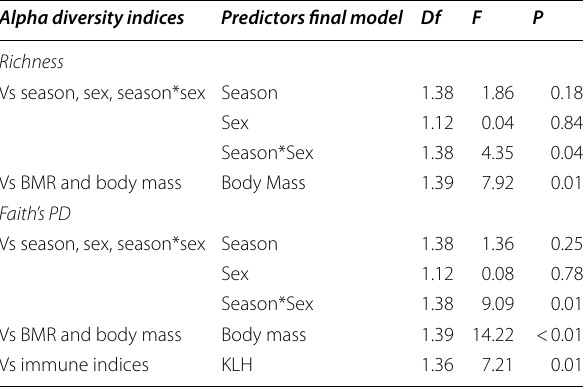
a Only the fixed factors of the final models are presented. Faith’s PD is Faith’s phylogenetic diversity. Units of the factors: season, summer and winter; sex, female and male; BMR, ml O 2 ∙h − 1 ; body mass, g; and KLH, antibody titre against immune index